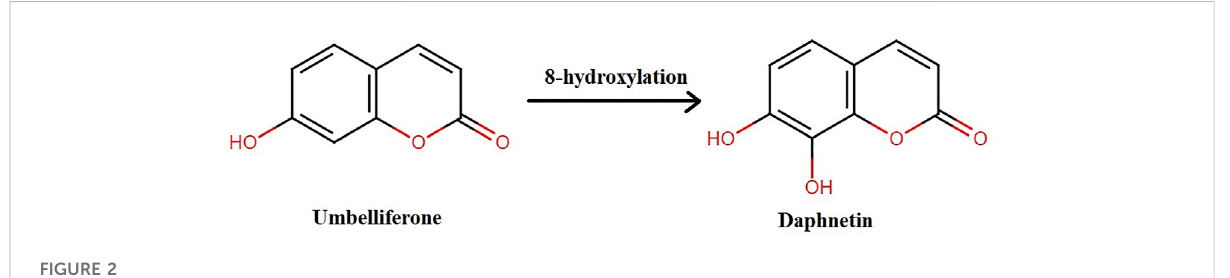
FIGURE 2 Synthesis of daphnetin.